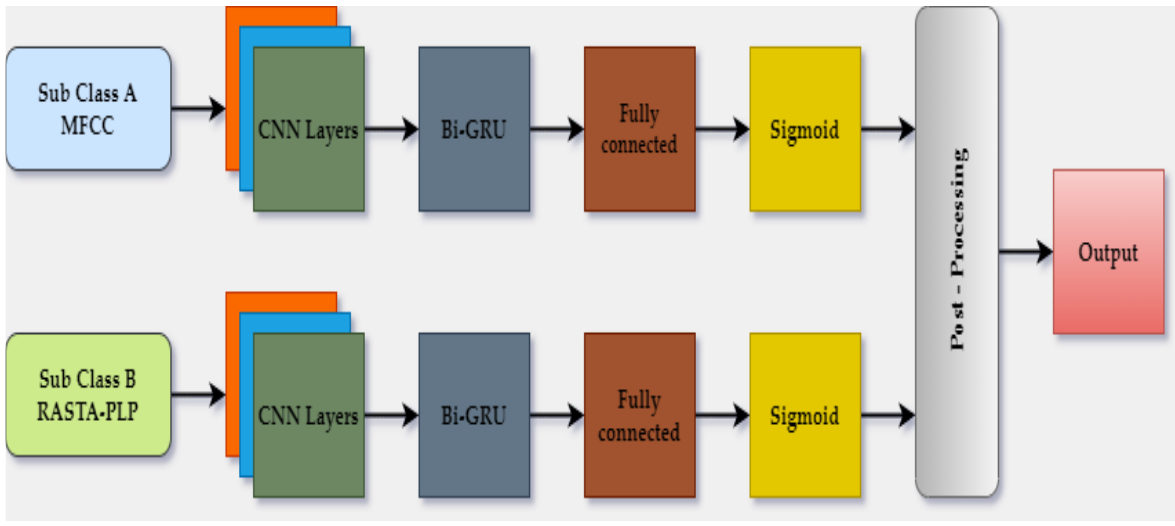
Figure 4. Block diagram of S-CRNN model .